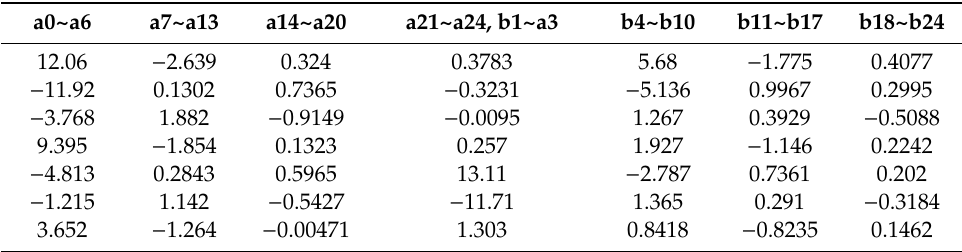
Figure 8. Pressure identification at A/F ratio 0.85.